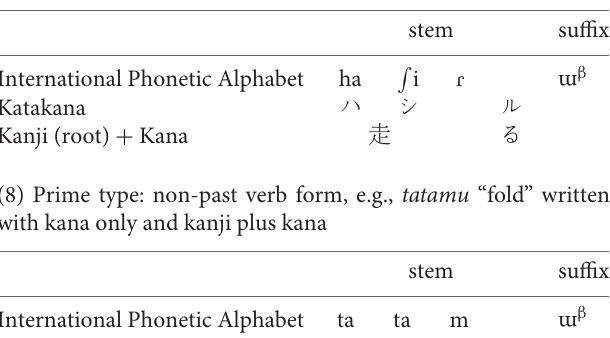
hashiru “run” written with kana only and kanji plus kana